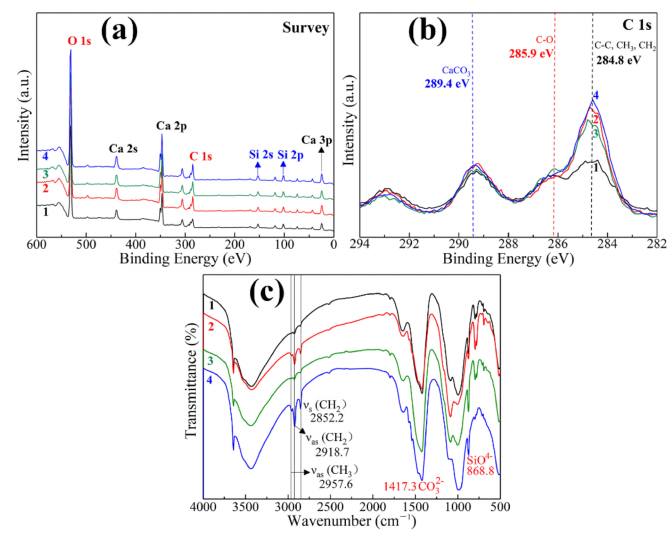
Figure 6. ( a ) X-ray photoelectron spectroscopy (XPS) survey spectra of various sample surface; ( b ) high resolution XPS spectra in C 1 s region of various sample surface; ( c ) attenuated total reflection Fourier transform infrared spectroscopy (ATR-FTIR) spectra of various sample surfaces. Curves 1, 2, 3, and 4 correspond to the following four samples, respectively: 1, Pure HCP; 2, HCP modified with 1.0 wt.% SL; 3, HCP modified with 1.0 wt.% NS; 4, HCP modified with 1.0 wt.% SL and 1.0 wt.% NS simultaneously.